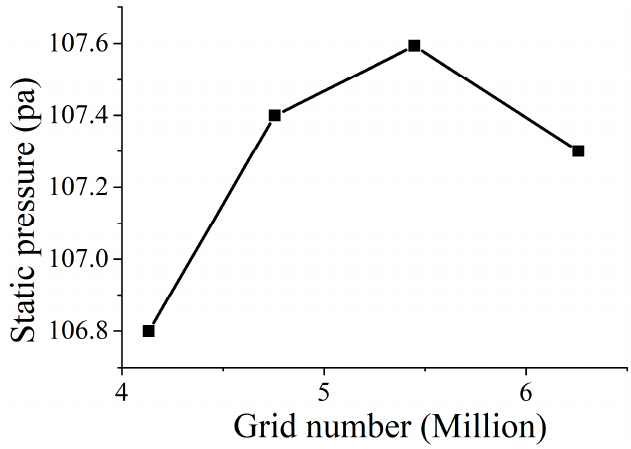
Figure 4 . Static pressure for different numbers of grids . Figure 4. Static pressure for di ff erent numbers of Table 2 . Number of grids in each fluid region of the centrifugal fan .